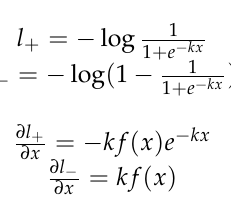
Figure 5. The flow chart of textbox inference.